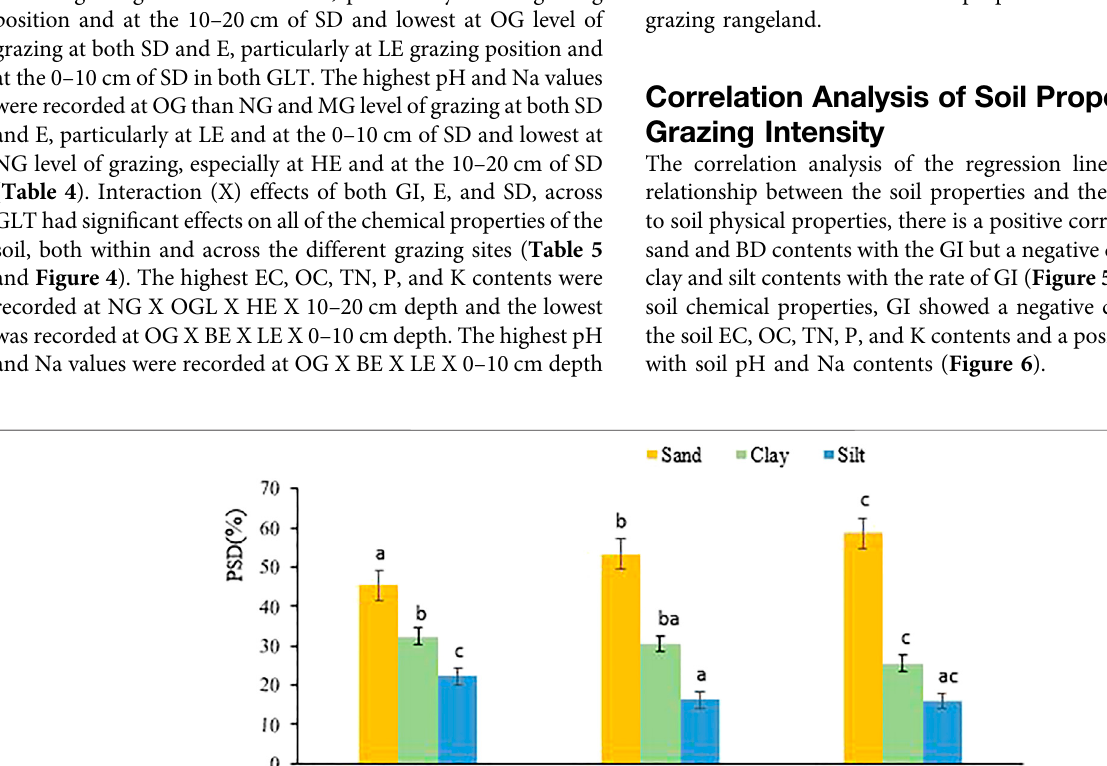
TABLE 4 | Mean ( ± SE) value of soil chemical properties distribution under different grazing land type, elevation, grazing intensity, and soil depths. Impacting factors andclass